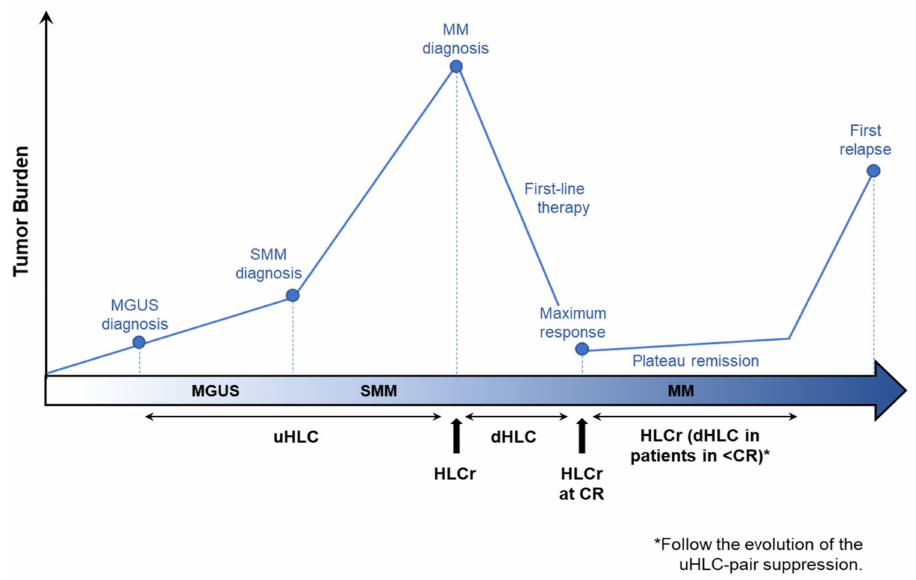
Figure 2. Heavy/light chain parameters providing most relevant information throughout